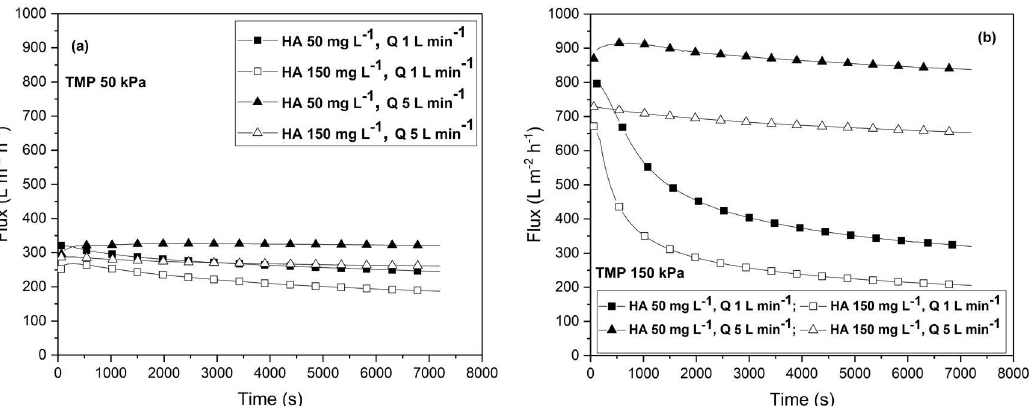
Figure 2. Time dependency of the permeate flux at the different operating conditions: ( a ) transmembrane pressure of 50 kPa and ( b ) transmembrane pressure of 150 kPa. The concentrations of humic acid (50 and 150 mg L −1 ) and the cross-flow rate (1, 5 L min −1 ) are varied.